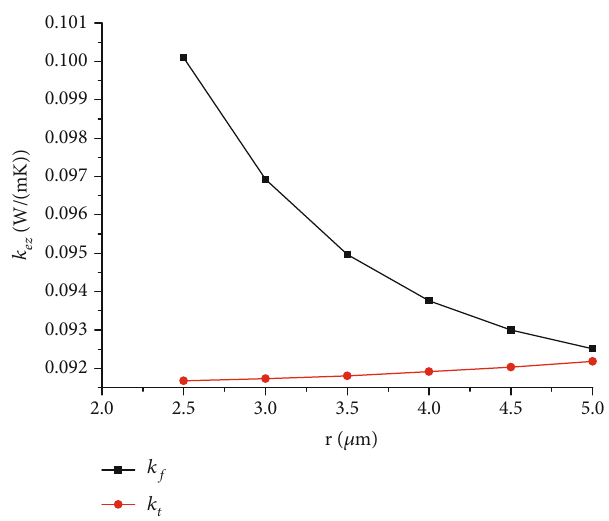
Figure 12: Variation of equivalent thermal conductivity with fi ber